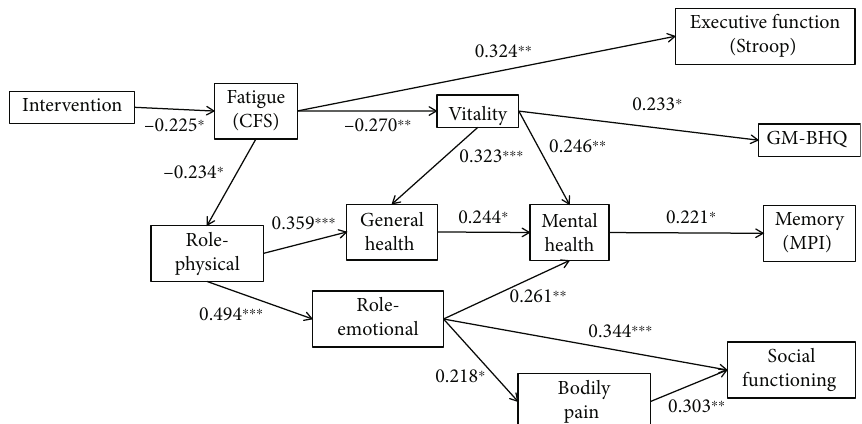
Figure 3: Elucidated association between intervention, fatigue, physical and mental conditions, and brain-derived measures. GFI = 0 : 950 ; AGFI = 0 : 921 ; NFI = 0 : 830 ; CFI = 1 : 000 . n = 88 ; ∗ p < 0 : 05 ; ∗∗ p < 0 : 01 ; ∗∗∗ p < 0 : 001 . Error term is